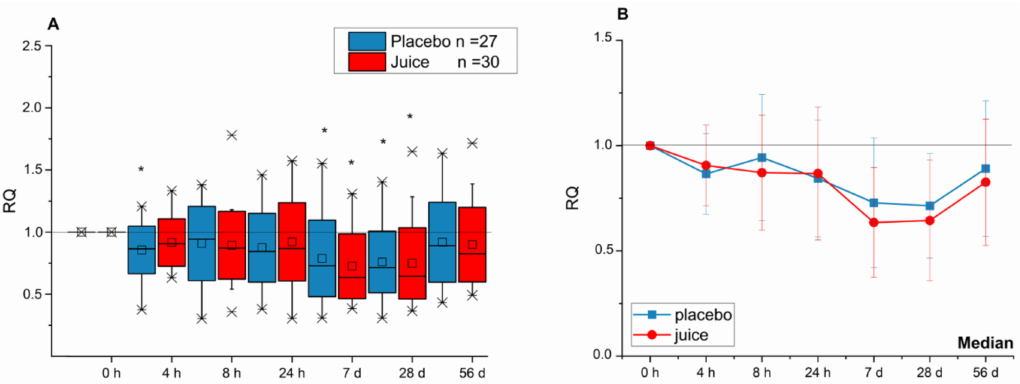
Figure 1. Modulation of NEF2L2 transcript levels after intake of anthocyanin-rich multi-fruit juice (juice, n = 30) or placebo beverage (placebo, n = 27) over time of intervention. ( A ) The transcript levels are normalized to the mean of transcript levels of ACTB and GAPDH and set in relation to the control (transcript levels at time point 0 h; relative transcription (RQ)). ( B ) Line graphs represent the median values of relative transcript levels (RQ) ± SD. Significance obtained when compared to the control is calculated by Kruskal–Wallis test with * = p <